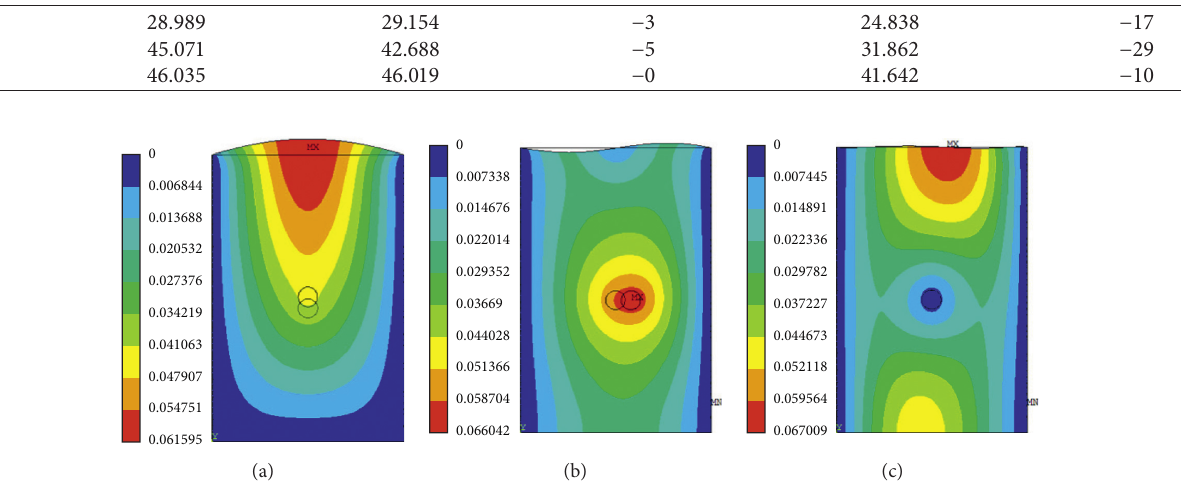
Figure 6: First 3-order mode shapes of polymer cutoff wall with slight damage in the middle part. (a) First vibration mode. (b) Second vibration mode. (c) Third vibration